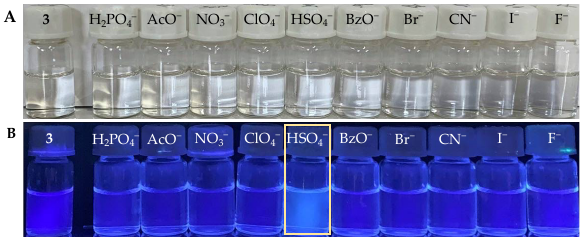
Figure 5. Solutions of compound 3 , in ACN/water (75:25) (1 × 10 −5 M), after adding 50 equivalents of anions, under natural light ( A ) and UV radiation at 365 nm ( B ).